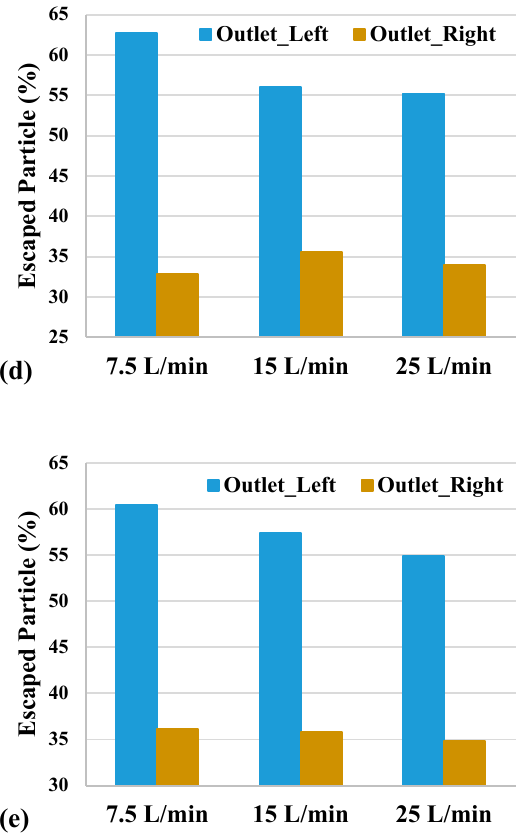
Figure 13. Escaped particles through the outlets of left and right lung airways with three airflow rates: ( a ) outlet definition; ( b ) 1 nm; ( c ) 10 nm; ( d ) 50 nm; and ( e ) 100 nm.